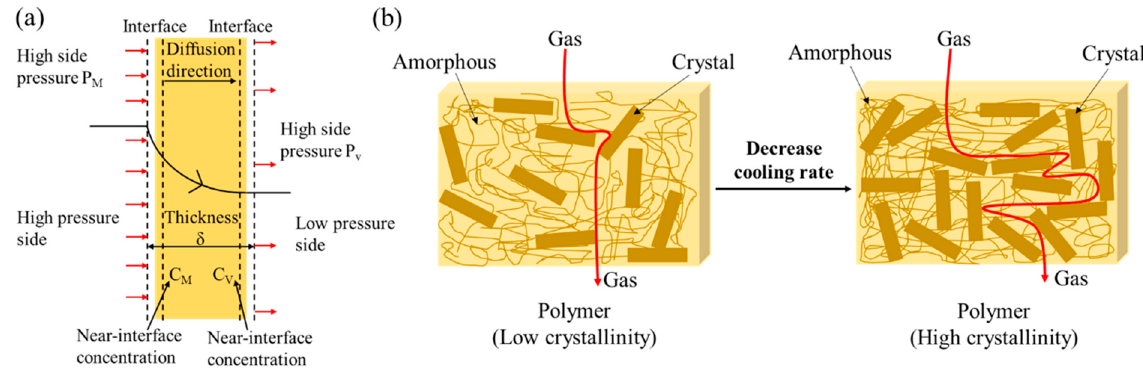
Figure 13. ( a ) Schematic diagram of the gas permeation process from the inner wall surface. ( b ) Gas permeation model.